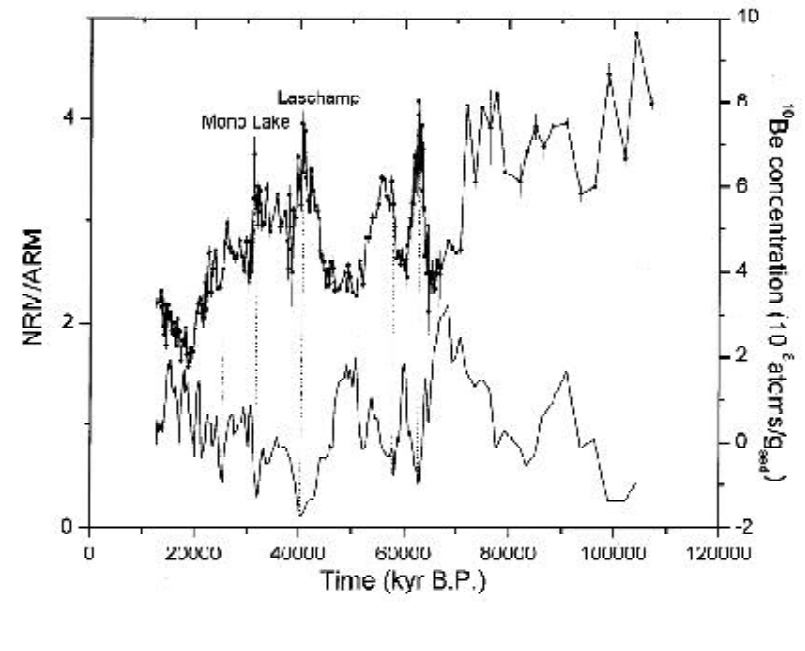
FIGURE 7. 10 Be concentrations (top line) from marine sediments from the Outer Blake Ridge off the southeastern coast of the U.S. (water depth ~3,800 m). NRM/ARM (Natural Remanent Magnetization normalized to Anhysteretic Magnetization) was measured from the same sediment samples[71] as those processed for 10 Be and is shown in the lower curve. Increases in 10 Be correlate with decreases in the paleomagnetic dipole field and are shown to be consistent with theoretical models for the relationship between the production of 10 Be in the atmosphere and the intensity of the geomagnetic field[62]. Sediments older than 65 ka are carbonate rich and thus interpretations of the intensity of the paleomagnetic signal are considered to be less reliable. The Laschamp geomagnetic excursion is interpreted from the work on this core and others on the Blake Ridge by Schwartz et al.[71] The Mono Lake excursion was assigned by correlation of 10 Be between the Blake Ridge and sediments from the Gulf of